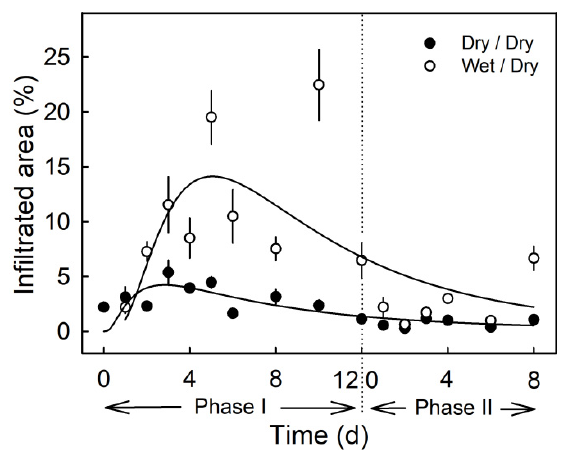
Figure 2. Time course of moisture-induced microcracking. Microcracking of the cuticle was indexed by quantifying the percentage of treated area infiltrated with acridine orange. The experiment comprised two phases: The first period of moisture exposure (Phase I) and the second period after termination of moisture exposure (Phase II). The end of Phase I and the beginning of Phase II is indicated by the dashed vertical line. The moisture treatment is referred to as ‘wet/dry’ and the control as ‘dry/dry.’ Data symbols present means ± SE ( n = 6 to 20).